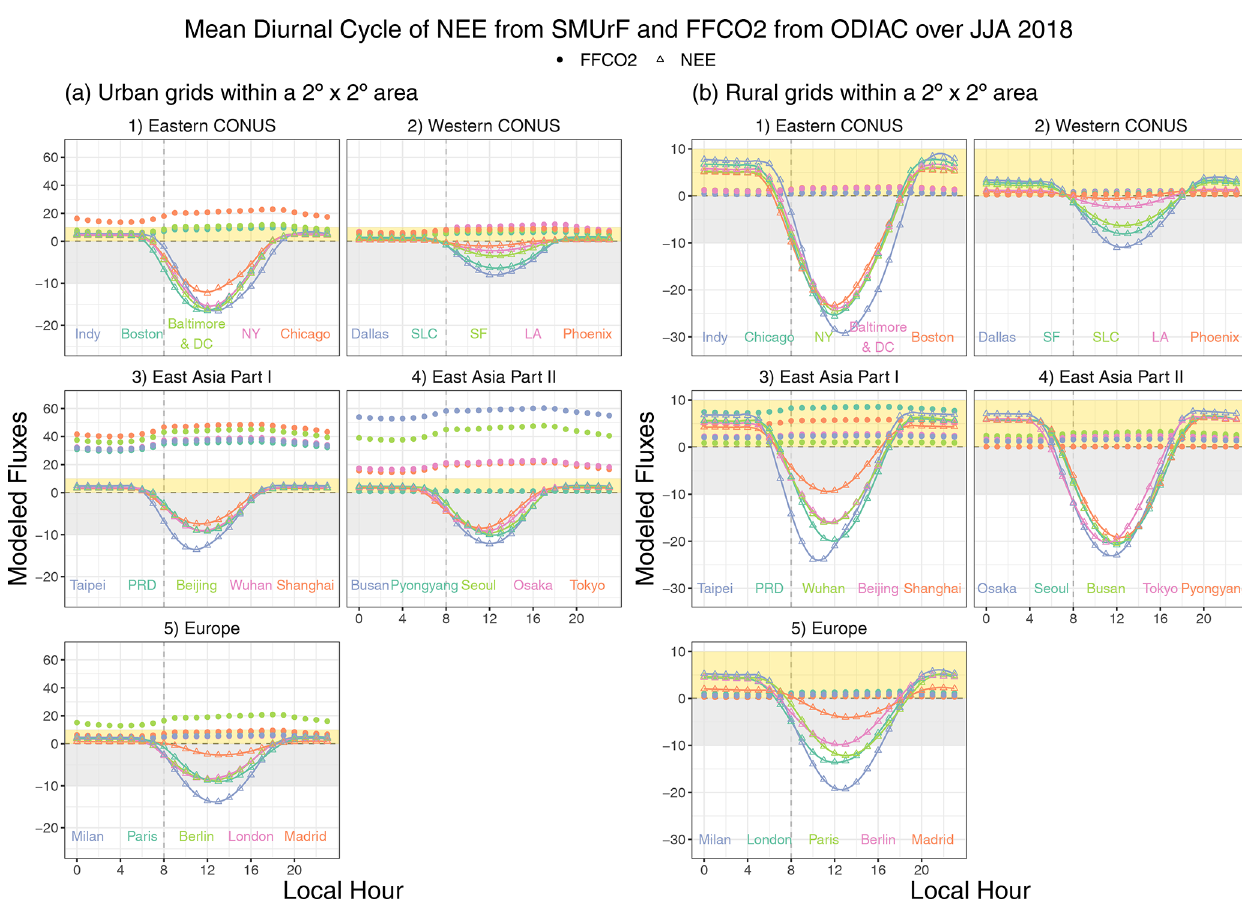
Figure 8. A multi-city comparison of the average diurnal cycles of SMUrF-derived NEE fluxes (triangles and solid lines) and ODIAC– TIMES based FFCO 2 (solid dots) [µmolm − 2 s − 1 ] over JJA 2018 for urban (a) and rural (b) grid cells within a 2 ◦ × 2 ◦ area around each urban center. Note that the y scales of positive and negative fluxes are different for panel (a) to better reveal the NEE fluxes, i.e., 0 to 60µmolm − 2 s − 1 for positive fluxes and − 20 to 0µmolm − 2 s − 1 for negative fluxes. Light gray ribbons indicate the negative flux ranges from − 10 to 0µmolm − 2 s − 1 , while light-yellow ribbons indicate the positive flux ranges from 0 to + 10µmolm − 2 s − 1 . City names are labeled at the bottom of each